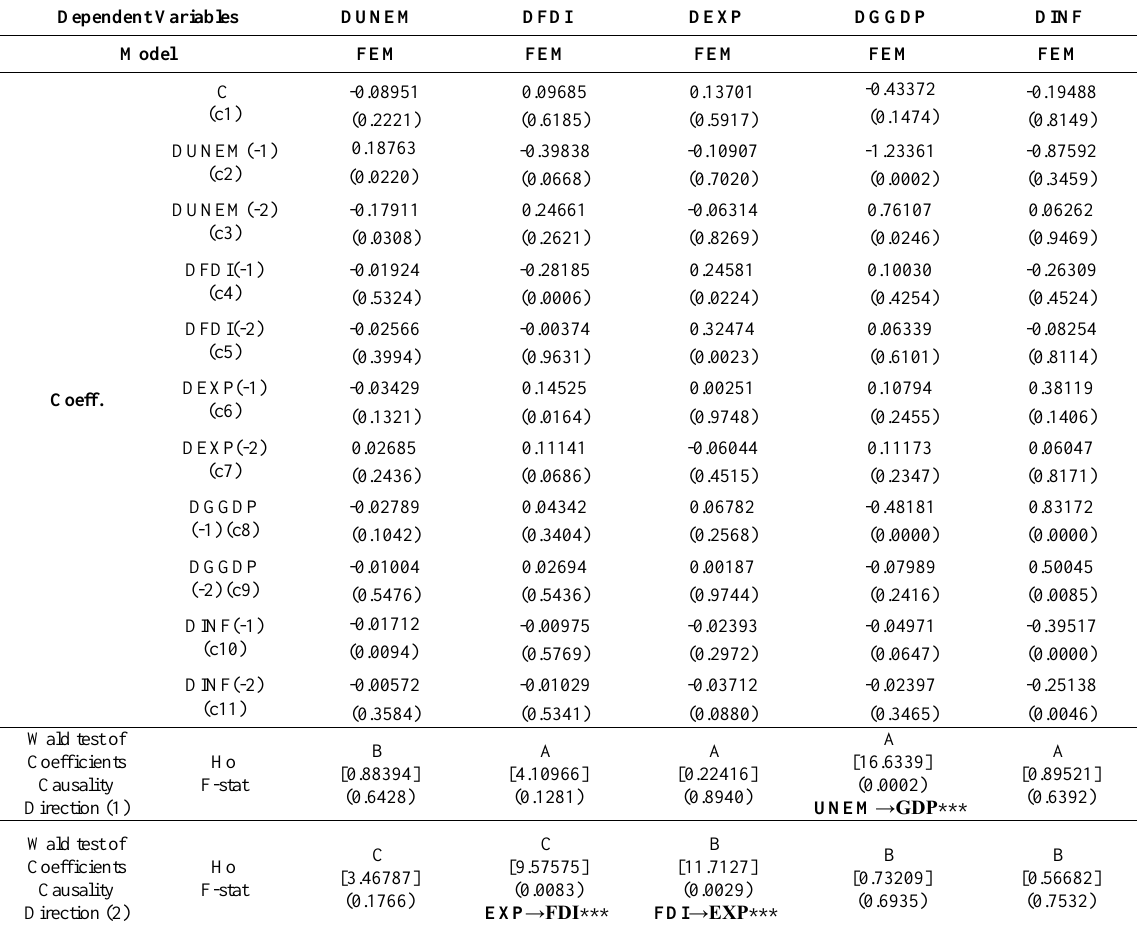
Table 9. Panel data Granger causality tests for the group of